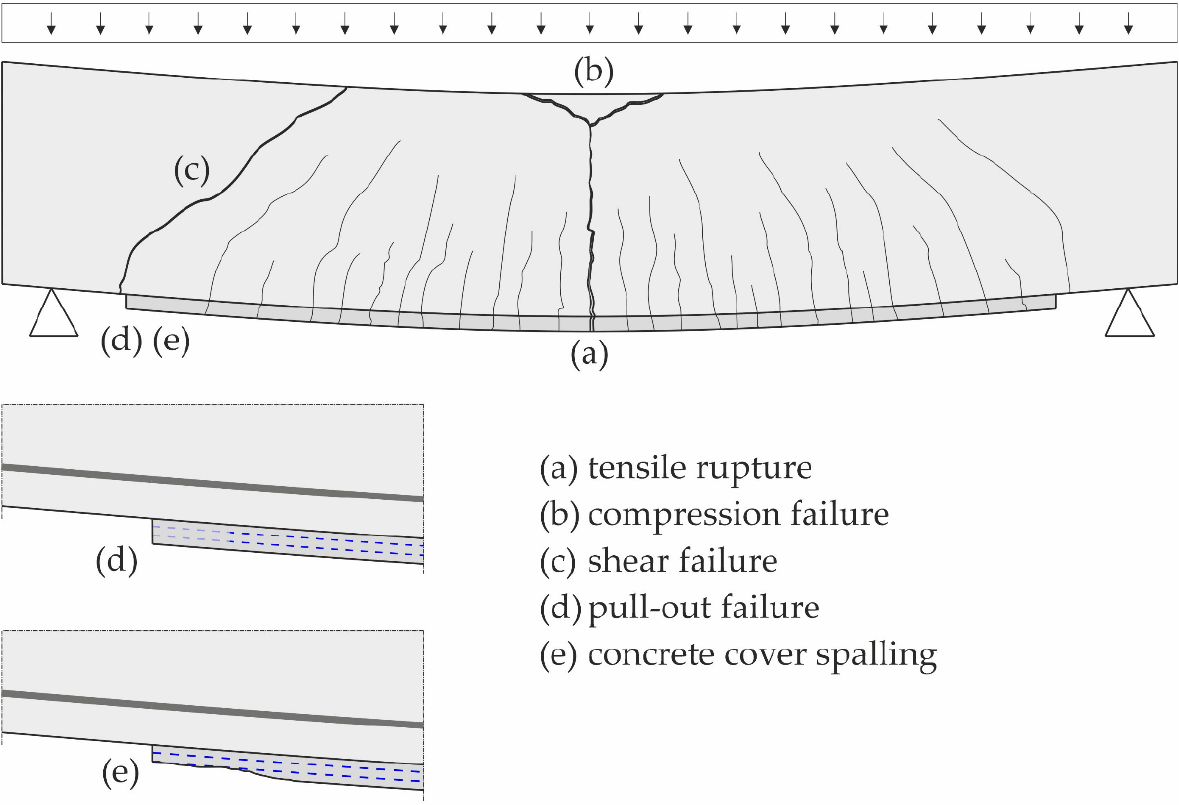
Figure 10. Common failure modes in reinforced concrete members strengthened with carbon reinforced concrete. (Graphic: CARBOCON GMBH).